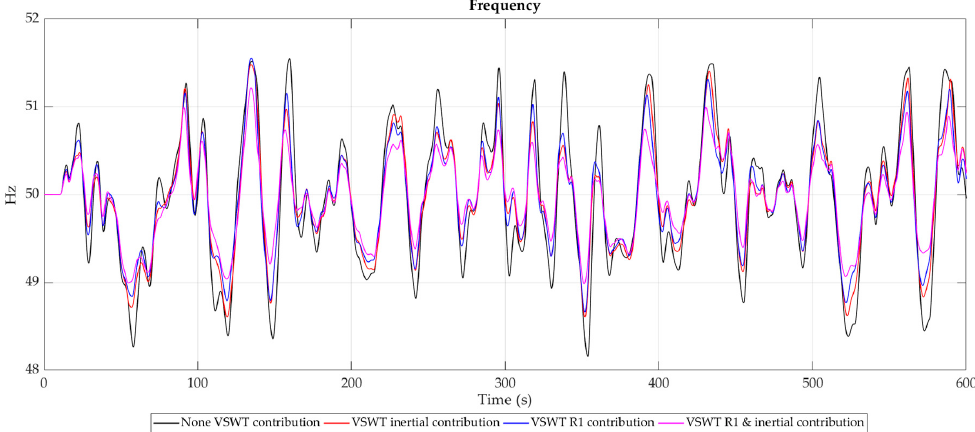
Figure 6. Frequency dynamic response in the cases none VSWT contribution, VSWT inertial contribution, primary frequency regulation (R1) contribution and R1 and inertial contribution (5% power reserve). Table 4 lists the average values of the hydraulic parameters: pumped and turbined water volumes and the sum of the wicket gate movements. On the one hand, pumped values do not vary significantly, regardless of the type of VSWT control strategy. Note that, according to the criteria described in Section 4.1, the initial power consumed by the pumps has remained constant in each